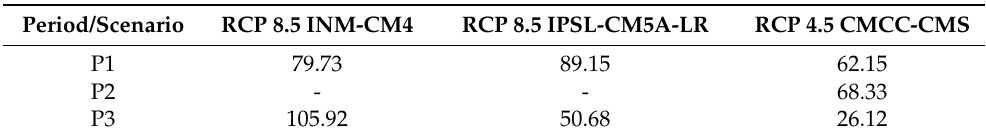
Table 11. Volume of water secured in the emergency storage (MCM) for Case 1, 2, and 3 in the Hapcheon Reservoir.